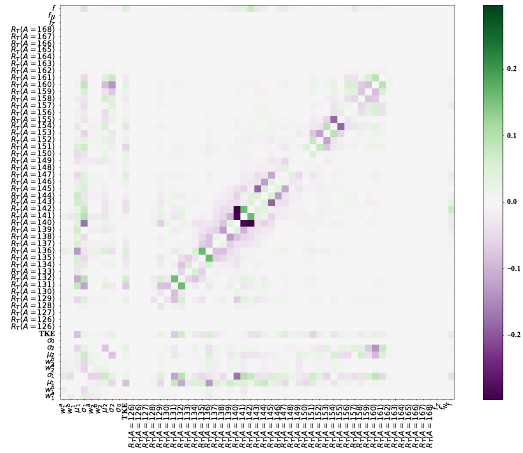
Figure 3. Di ff erence between the parameter correlation matrix using the EXFOR optimization and the ENDF optimization (Fig. 2(b) minus